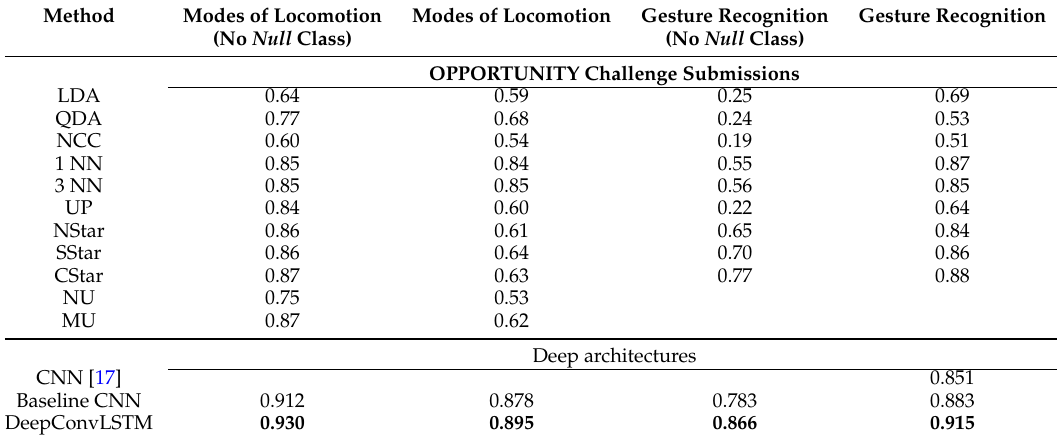
Table 4. F 1 score performance on OPPORTUNITY dataset for the gestures and modes of locomotion recognition tasks, either including or ignoring the Null class. The best results are highlighted in